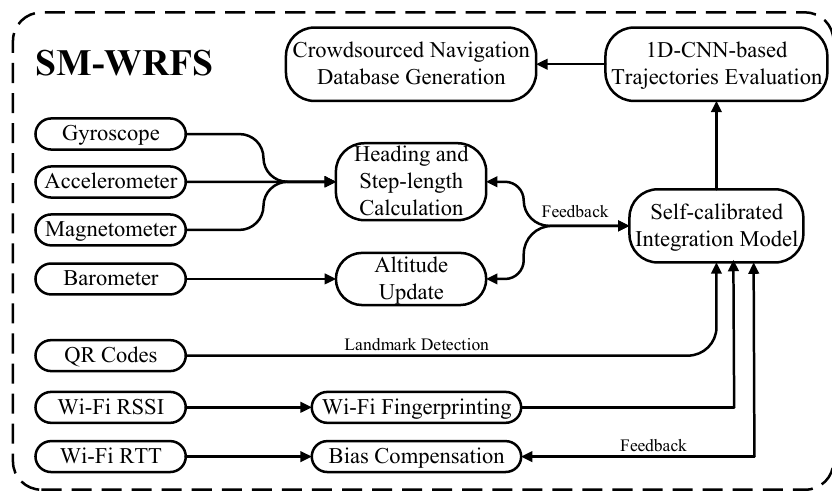
Figure 1. Overall flow of proposed SM-WRFS structure.